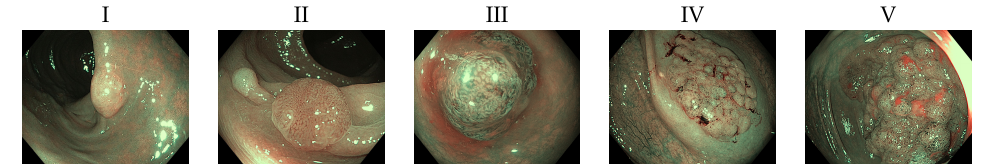
Figure 1. Examples of Kudo’s classification scale of Polyps ranging from I through